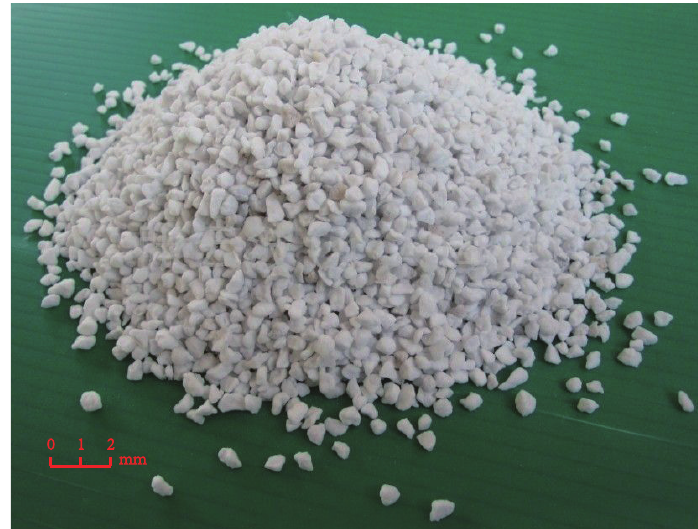
Figure 1. Appearance of vitrified microspheres.